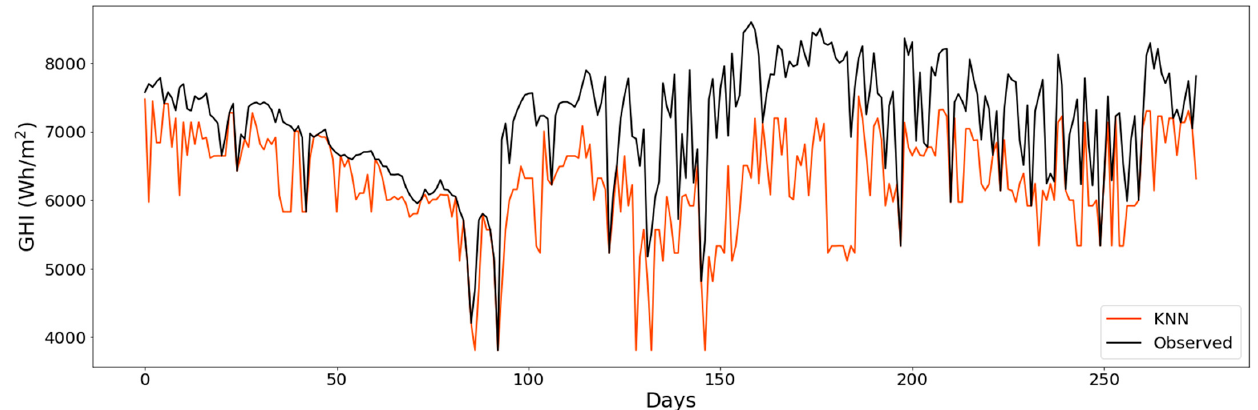
Figure 5. Graphical representation of KNN predictions.